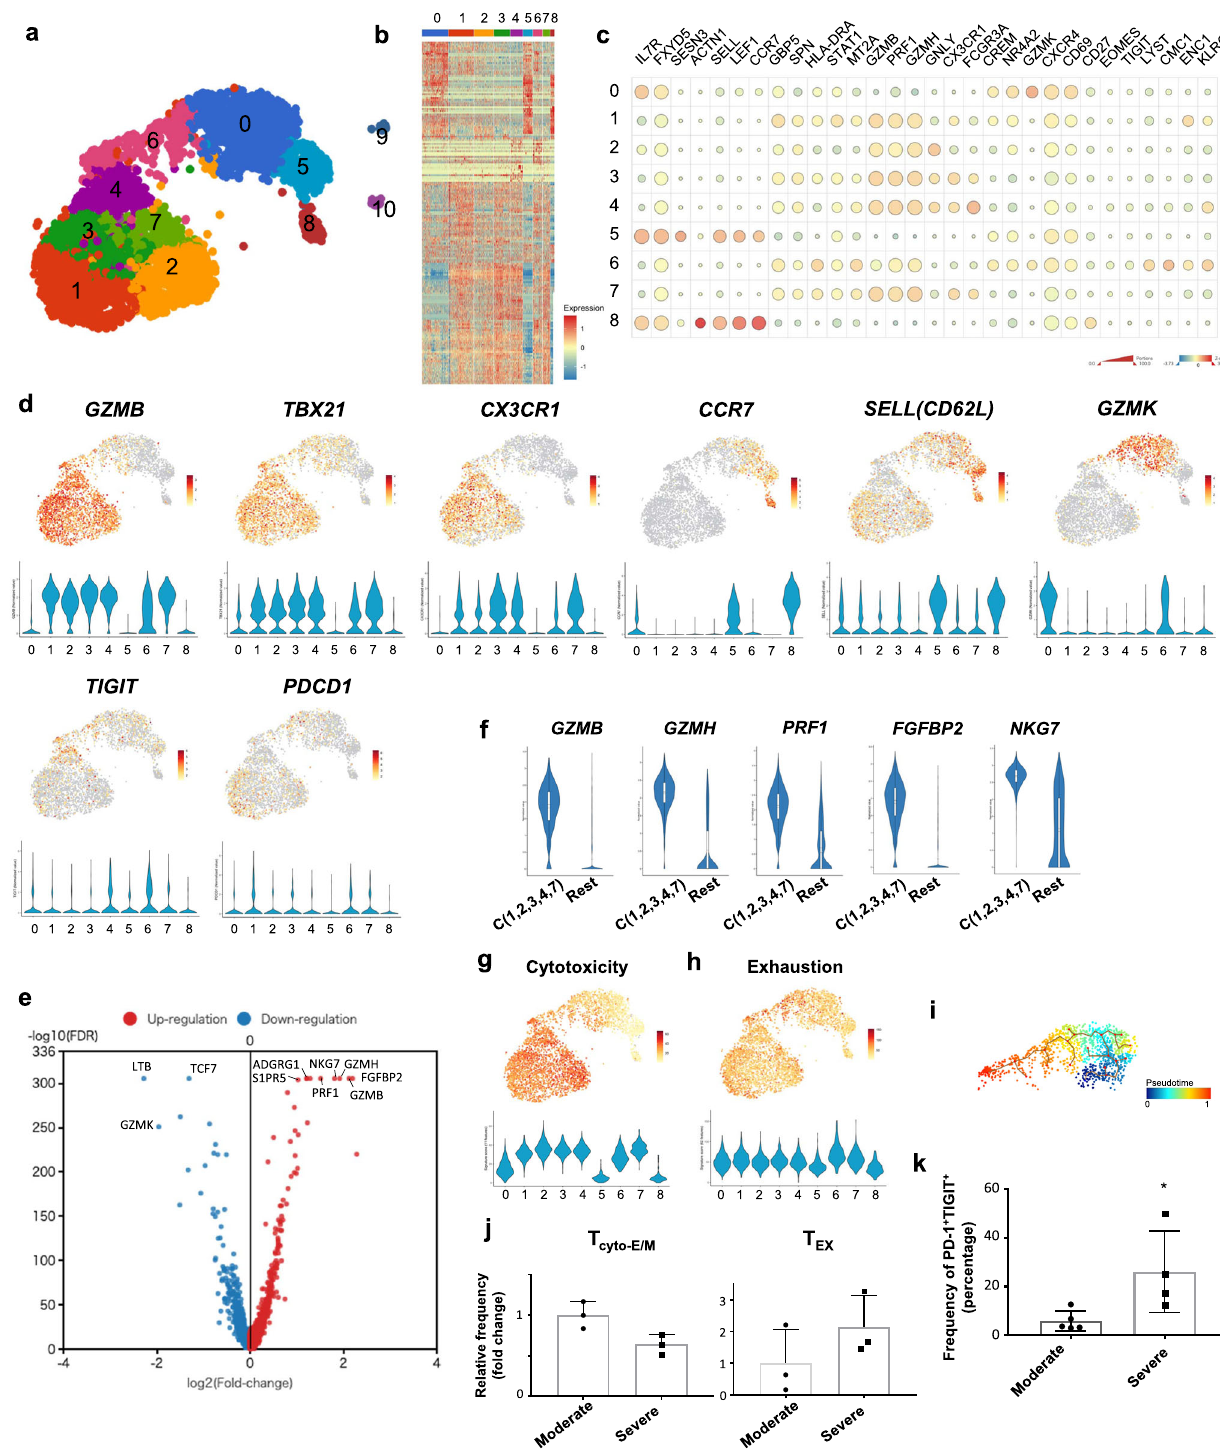
Fig. 5 | Single-cell RNA-sequencing of M198 – 206-speci fi c CD8+ T cells. a UMAP analysis displays transcriptomic landscape of M 198 – 206 -speci fi c CD8 + T cells. Each dot corresponds a single cell and is colored according to the cluster. b Heatmap representationoftop50differentiallyexpressedgenesofeachcluster(eachcluster vs. rest). c Mean expression (color) and frequency of expressing cells (size) of the featuredgeneswereshowninthegraph. d UMAPsareillustratingmRNAexpression of the indicated genes. The expression level of the indicated genes of each cluster was shown in the violin plot. e Volcano plot shows fold changes of differentially expressedgenesbetweencluster(1,2,3,4,7)andtherest. f ViolinplotshowsmRNA expression of indicated genes in cluster (1, 2, 3, 4, 7) ( n =2727 cells) and the rest